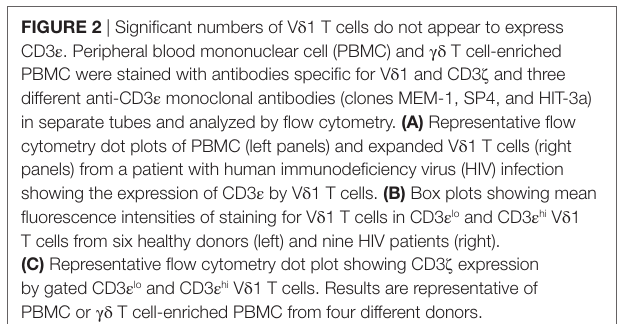
FigUre 2 | Significant numbers of V δ 1 T cells do not appear to express CD3 ε . Peripheral blood mononuclear cell (PBMC) and γδ T cell-enriched PBMC were stained with antibodies specific for V δ 1 and CD3 ζ and three different anti-CD3 ε monoclonal antibodies (clones MEM-1, SP4, and HIT-3a) in separate tubes and analyzed by flow cytometry. (a) Representative flow cytometry dot plots of PBMC (left panels) and expanded V δ 1 T cells (right panels) from a patient with human immunodeficiency virus (HIV) infection showing the expression of CD3 ε by V δ 1 T cells. (B) Box plots showing mean fluorescence intensities of staining for V δ 1 T cells in CD3 ε lo and CD3 ε hi V δ 1 T cells from six healthy donors (left) and nine HIV patients (right). (c) Representative flow cytometry dot plot showing CD3 ζ expression by gated CD3 ε lo and CD3 ε hi V δ 1 T cells. Results are representative of PBMC or γδ T cell-enriched PBMC from four different